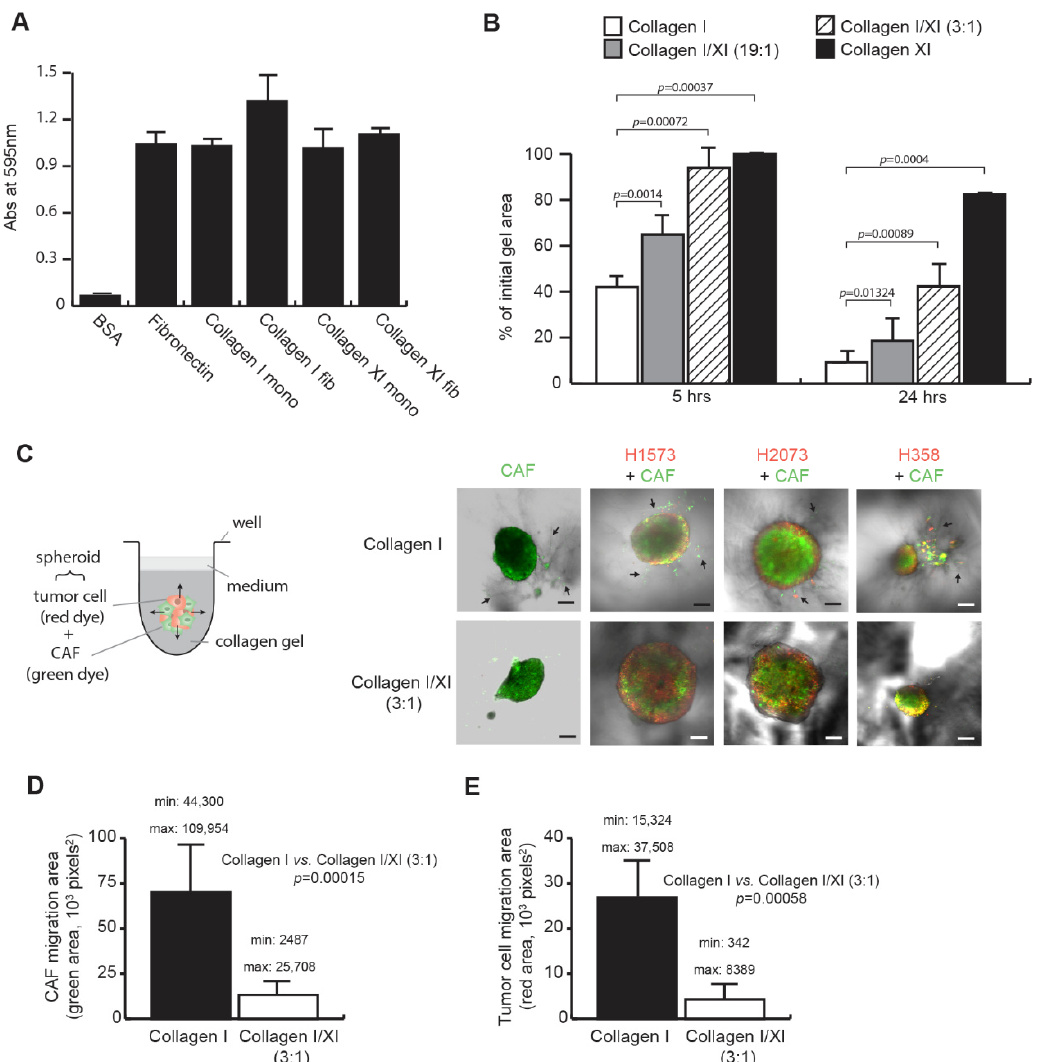
Figure 1. Collagen type XI inhibits cancer-associated fibroblast (CAF) functions. ( A ) CAFs bind to collagen type XI. CAFs were seeded on monomeric (mono) or fibrillar (fib) collagen type I and collagen type XI for 40 min. Cells were stained with crystal violet and absorbance was read at 595 nm. Bovine serum albumin (BSA) and fibronectin were used as negative and positive control for cell adhesion, respectively, ( n = 4, mean ± SD). ( B ) Collagen type XI delays CAF-mediated collagen matrix remodeling. CAFs were embedded in a matrix of collagen type I, collagen type XI or a mix of both collagens at a ratio of 19:1 and 3:1 (collagen type I:collagen type XI), and allowed to contract the matrix for 24 h. Area of the collagen matrices has been measured at 5 and 24 h. Statistics were performed using a Mann–Whitney test ( n = 8, mean ± SD). ( C ) Collagen type XI inhibits CAF-mediated lung tumor cell migration. Heterospheroids of CAFs (stained with a green dye) and lung tumor cells (stained with a red dye) were embedded in a matrix of collagen type I or a mix of collagen type I and collagen type XI at a 3:1 ratio. The invasion into the collagen matrices was visualized for 2 days using confocal microscopy, scale bars: 200 µm. Arrows denote tracks in the collagen matrix made by migrating CAFs. The migrated area in the collagen matrices was quantified for CAF ( D ) and lung tumor cells ( E ) for the three different heterospheroids presented in C and has been averaged. Minimum and maximum values are indicated in each graph. Statistics were performed using a Mann–Whitney test ( n = 8, mean ± SD).